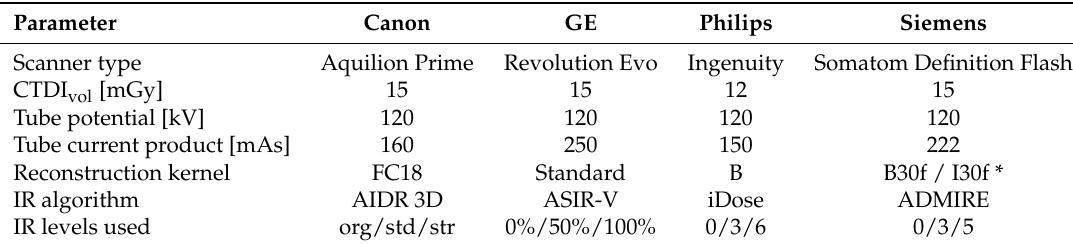
Table 1. Scan- and reconstruction parameters for all